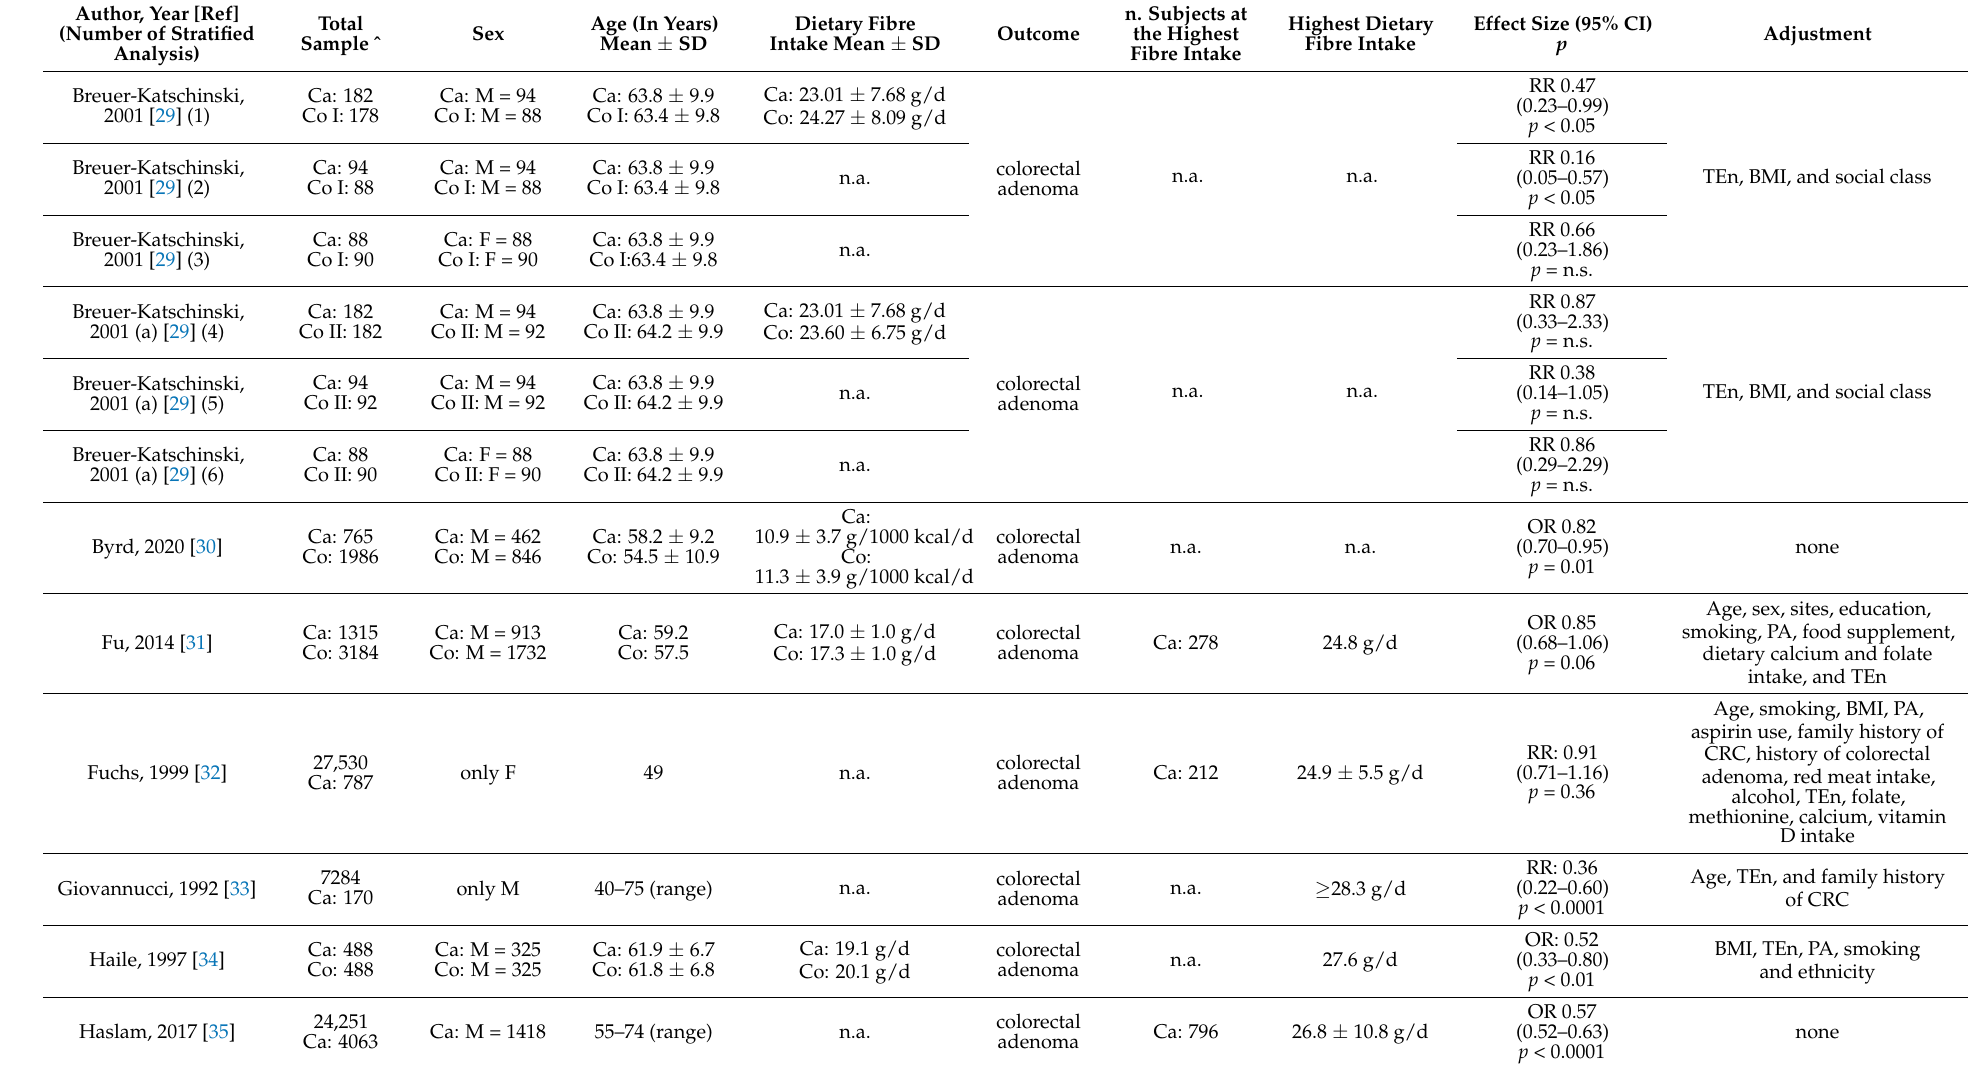
Table 2. Quantitative characteristics of included studies, reported in alphabetical